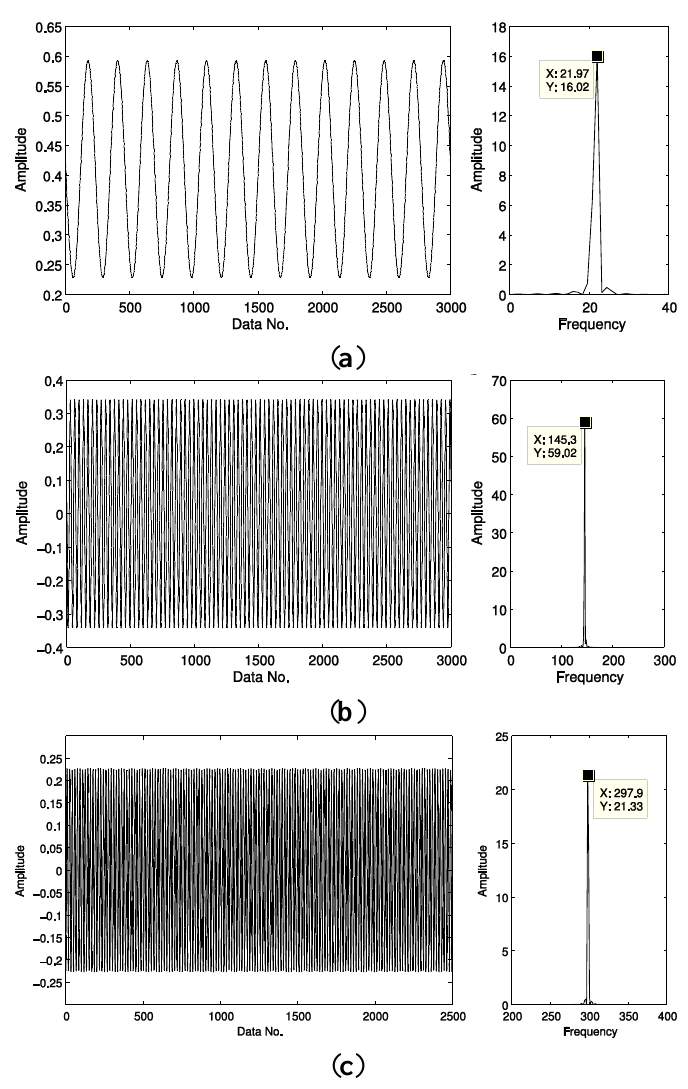
Figure 10. Harmonics detected and their frequencies from envelope samples of the signal shown in Figure 9: ( a ) the first harmonic and its frequency; ( b ) the third harmonic and its frequency; ( c ) the fifth harmonic and its